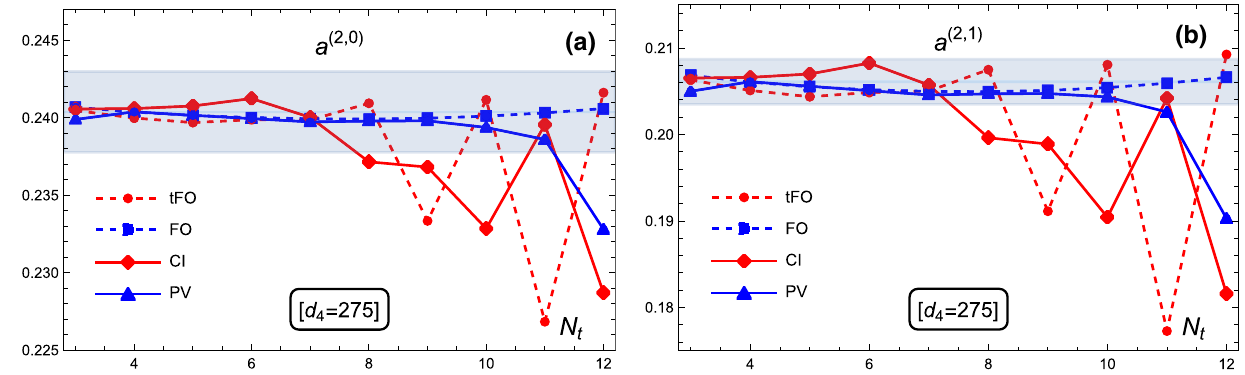
Fig. 4 The moment a ( 2 , 0 ) (σ m ) ( a ) and a ( 2 , 1 ) (σ m ) ( b ), as a function of the truncation index N t , in the four considered approaches. At each N t , the corresponding values of the parameters α s and (cid:10) O D (cid:11) obtained